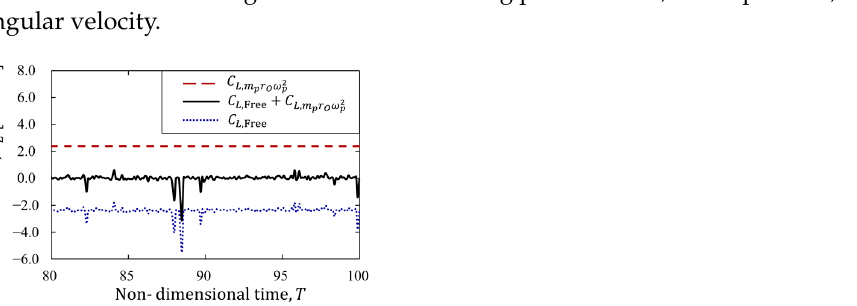
Figure 9. Lift force acting on the particle for its inner wall side equilibrium position for 𝑙 = 400 cells, 𝑅𝑒 = 32 and 𝐶 = 0.10 from 80 to 100 non-dimensional time.